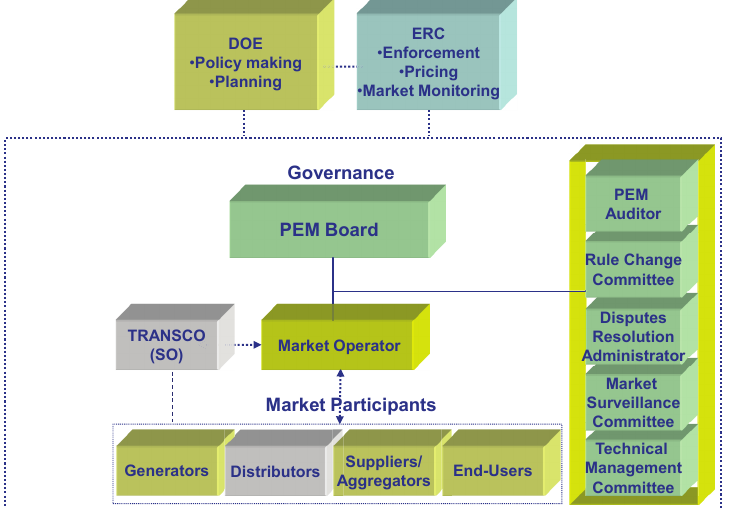
Figure 1. Wholesale Electricity Spot Market (WESM)